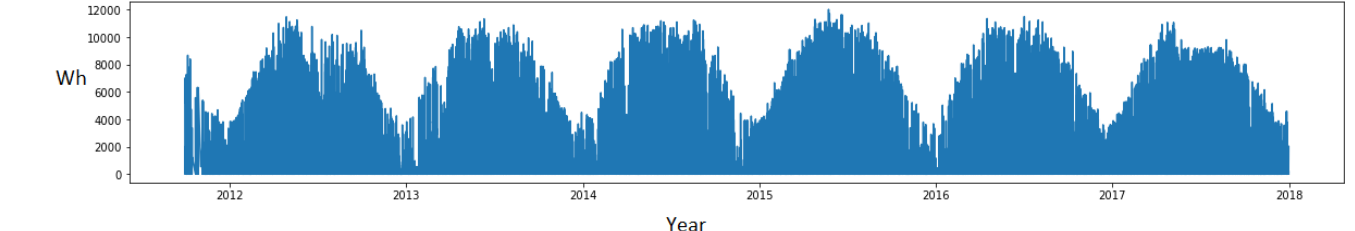
Figure 1. Representation of the whole dataset.